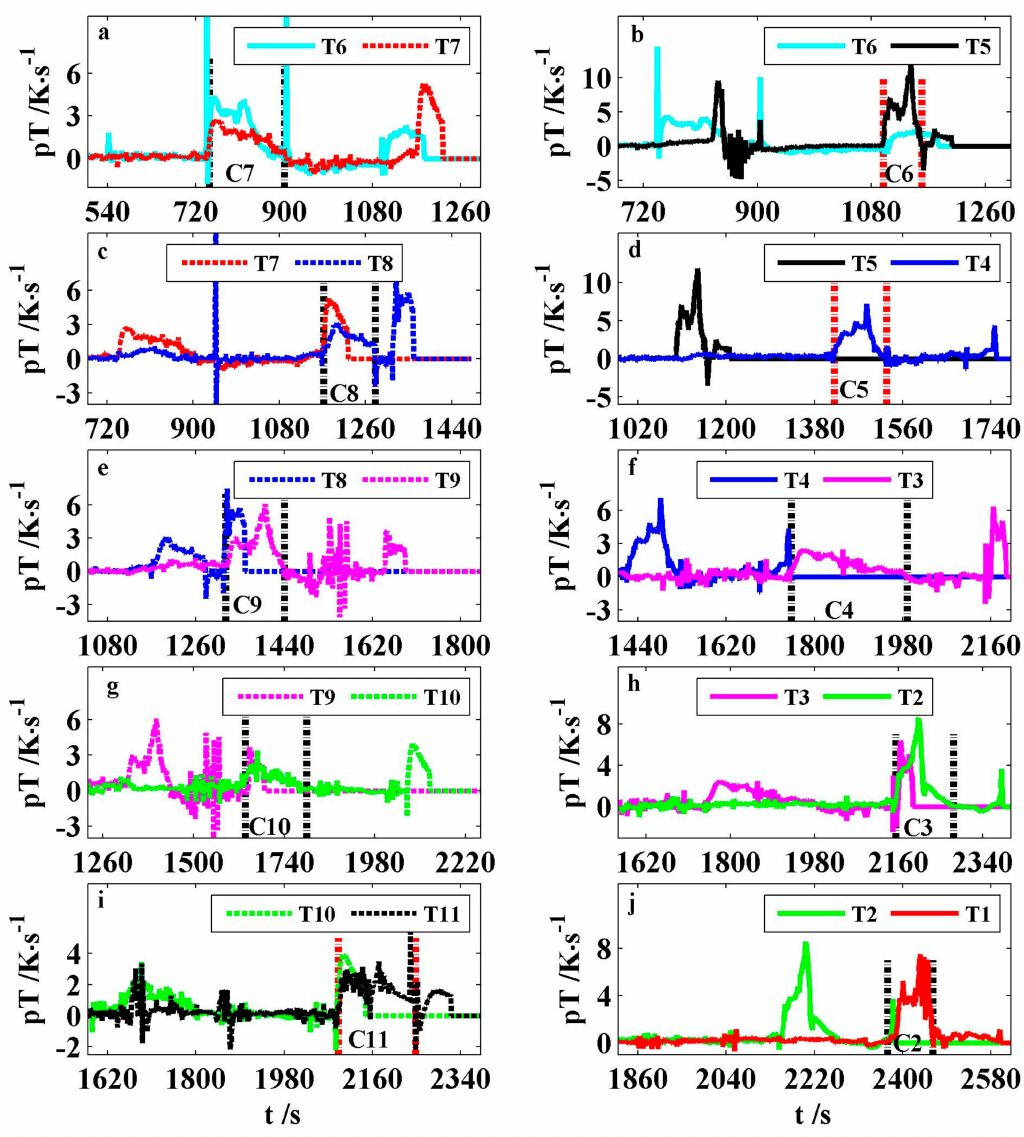
Figure 9. Pole temperature rates during thermal runaway: each ISC interval between both vertical lines in the